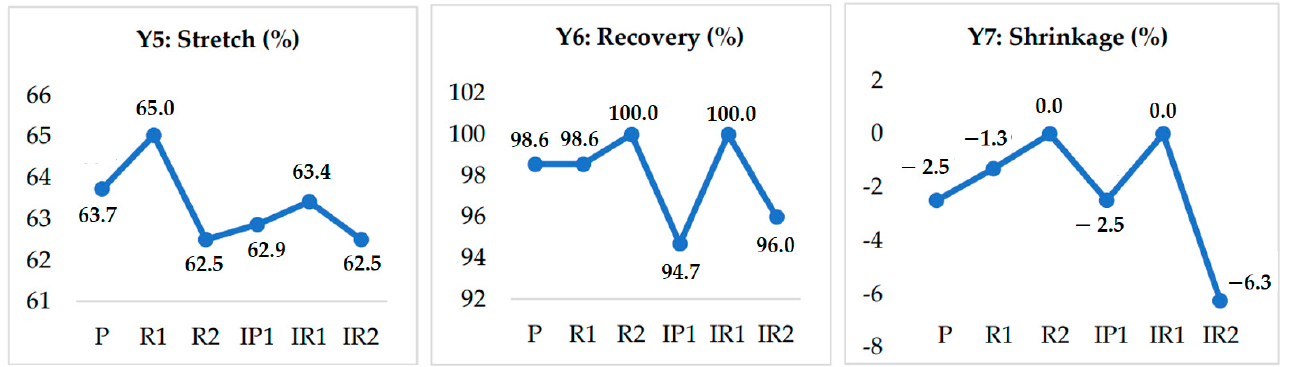
Figure 6. Dimensional properties of compression stockings.